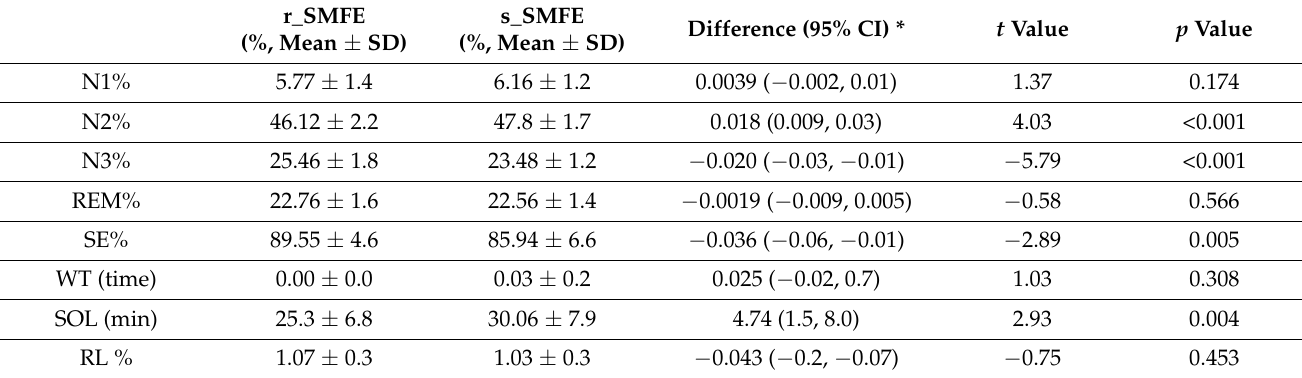
Table 4. Comparisons of EEG sleep variables among the two